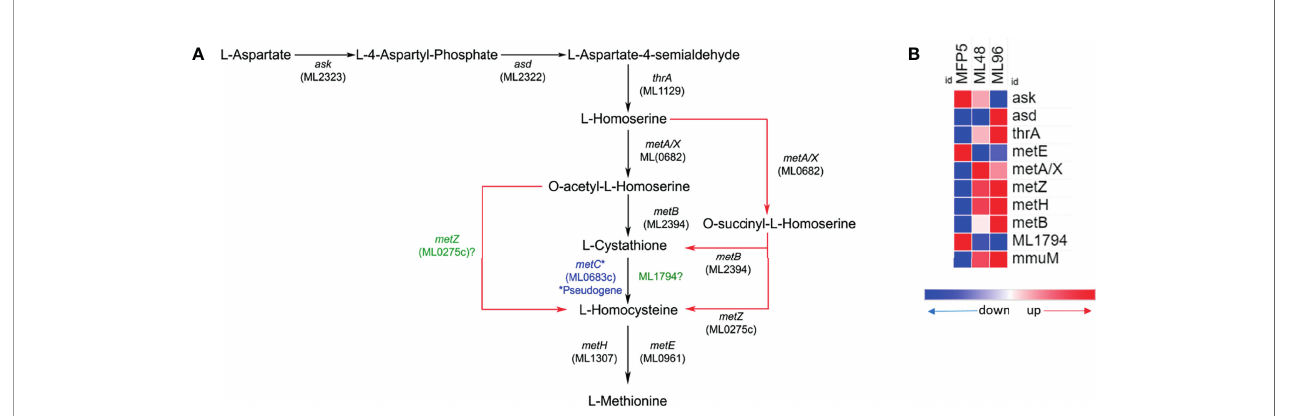
FIGURE 4 | Potential alternate (red arrows) methionine biosynthesis pathway (adopted from KEGG pathway database - https://www.genome.jp/pathway/mle00270) in M. leprae (A) and expression levels (average abundance) of methionine biosynthesis pathway protein genes in M. leprae under in vivo (MFP5) and in vitro (ML48 & ML96) conditions (B)